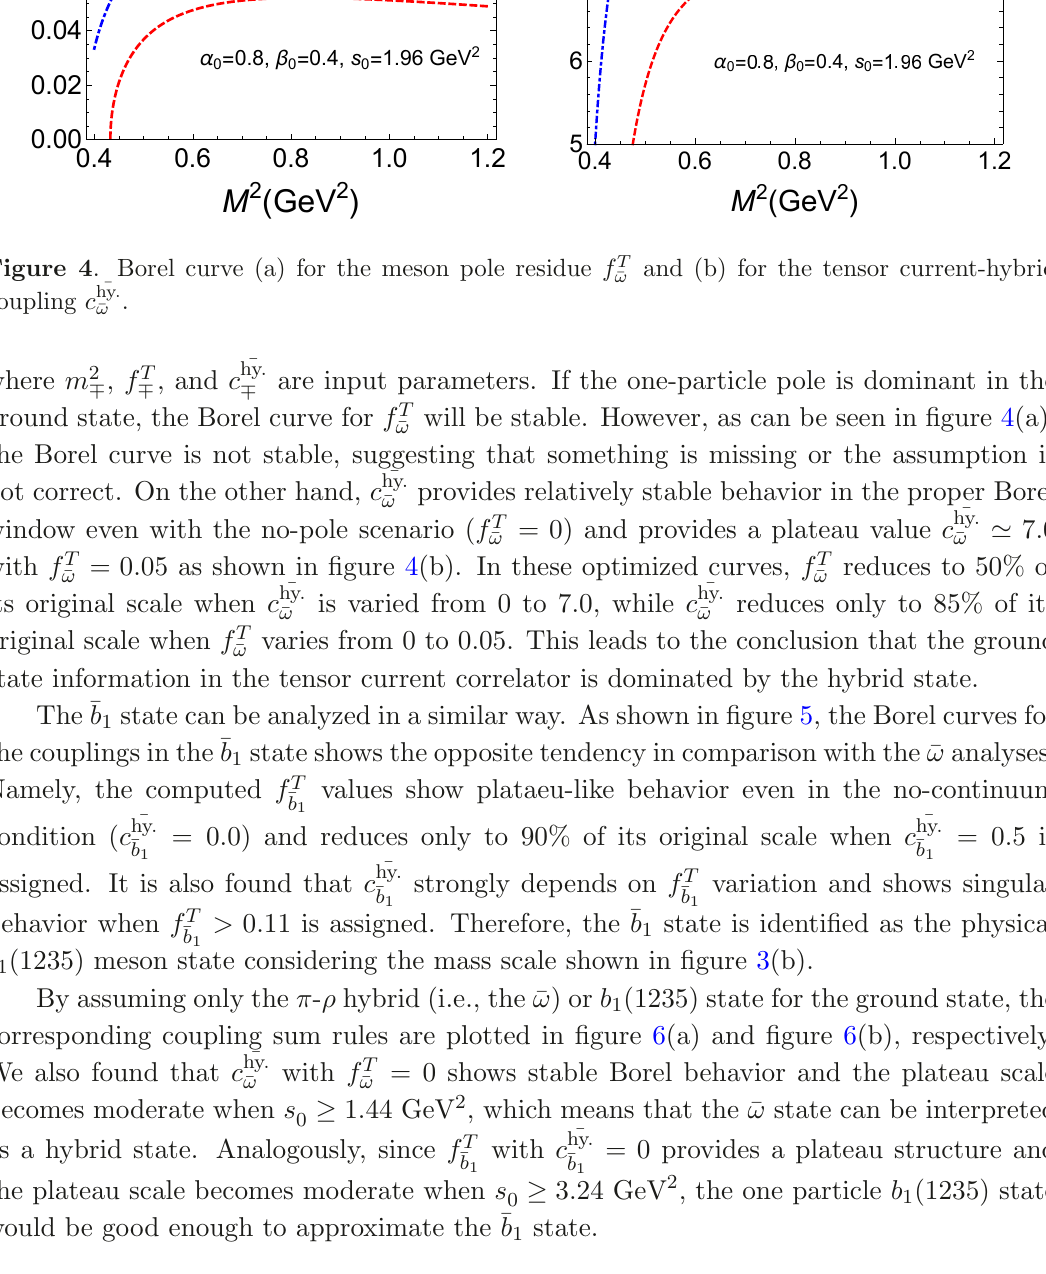
and (b) for the tensor current-hybrid ¯ ω